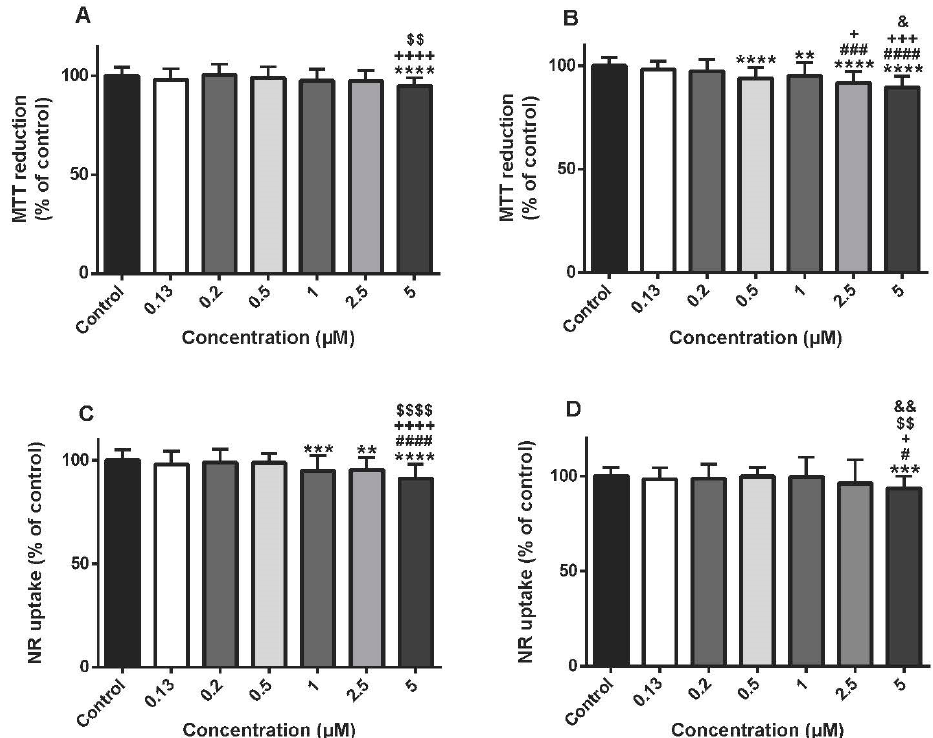
Figure 2. Mitochondrial and lysosomal dysfunction evaluated by the MTT reduction assay ( A , B ) and the NR uptake assay ( C , D ), respectively, in differentiated H9c2 cells incubated with 0.13, 0.2, 0.5, 1, 2.5, 5 µ M of 5-fluorouracil (5-FU) for 24 ( A , C ) and 48 h ( B , D ). Results are presented as mean ±